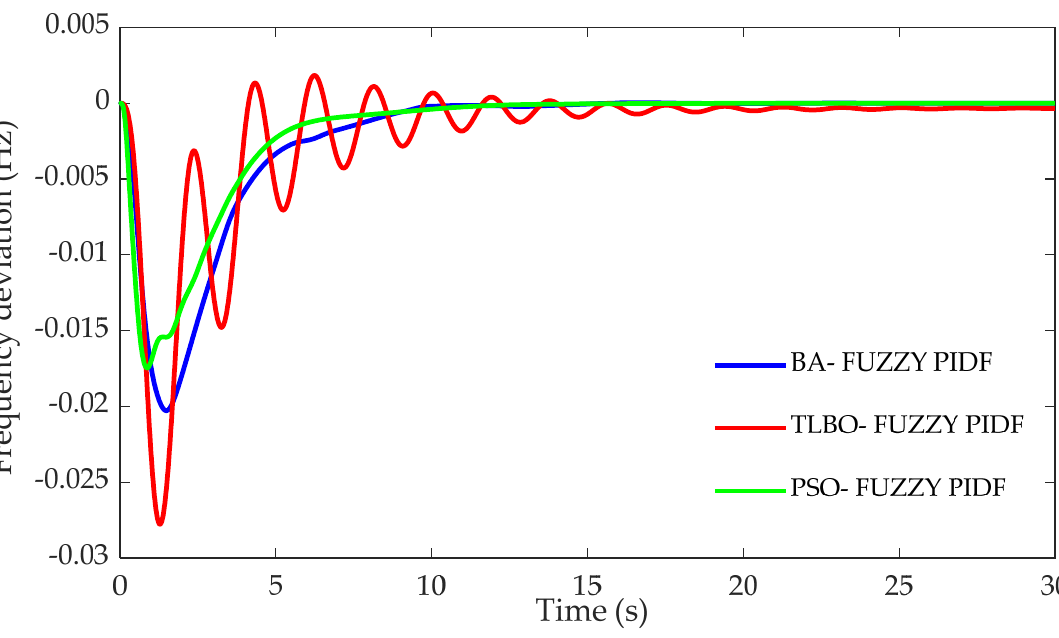
Figure 10. Frequency deviation in area two ( ∆ F 2 in Hz) under parametric uncertainties of the testbed system.